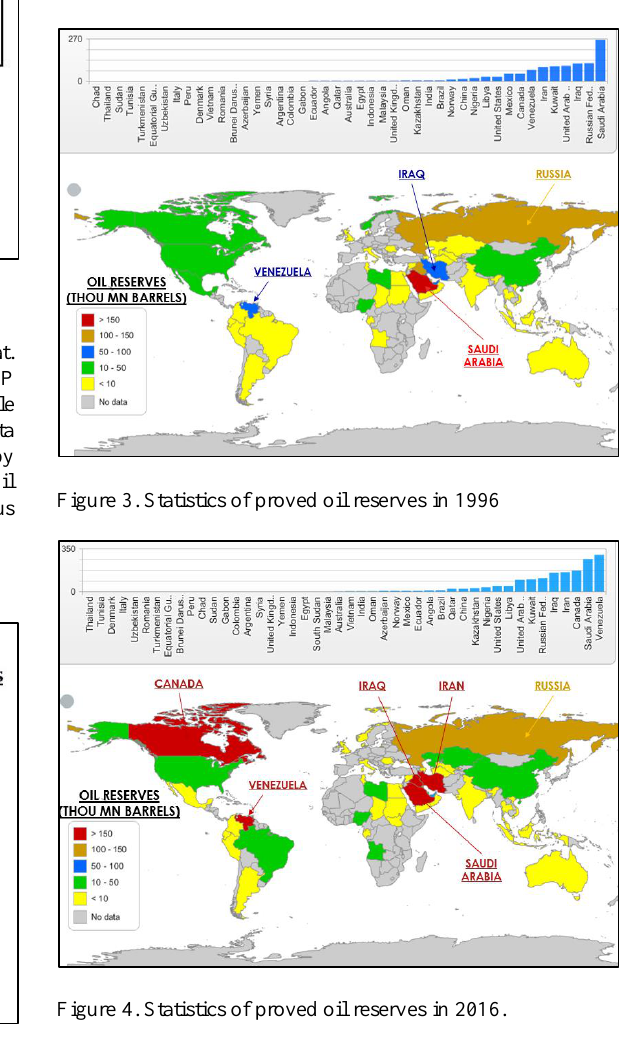
Figure 2. Flowchart of activities in Petroleum trade.